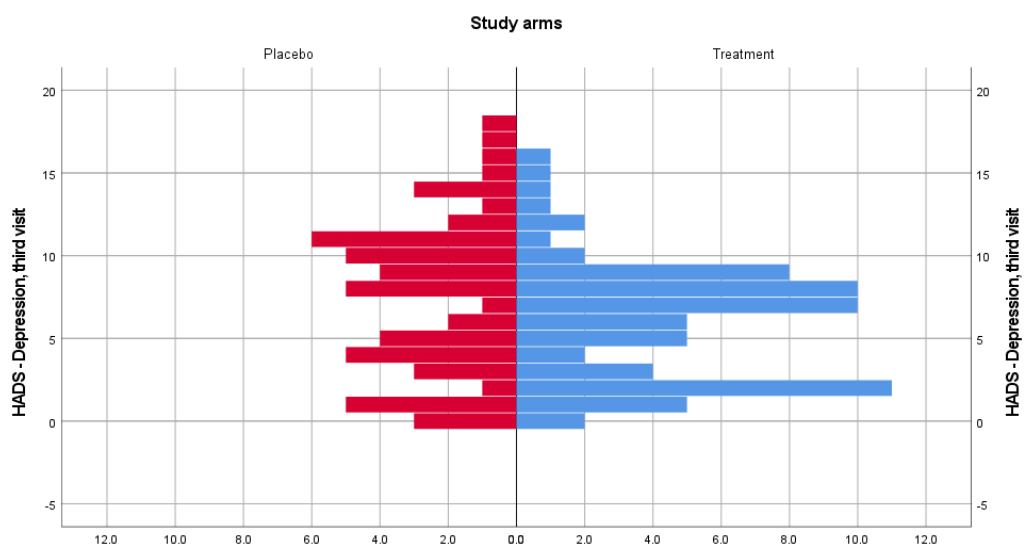
Figure 3. HADS − Depression score distribution for the treatment and placebo groups for the second visit.